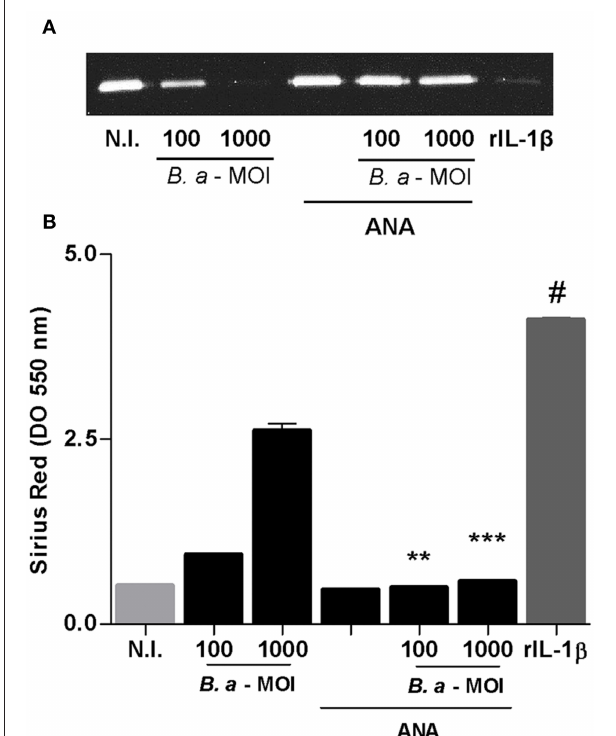
FIGURE 6 | IL-1 β is involved in the induction of a profibrogenic phenotype. LX-2 cells were infected with B. abortus at MOI of 100 and 1000 in the presence or not of ANAKINRA (ANA). Determination of MMP-9 at 24h post-infection in culture supernatants by zymography (A) . Recombinant human IL-1- β , (rIL-1 β ) (50ng/ml) was used as a positive control. Quantification of collagen deposition was revealed by Sirius red staining by OD readings at 550nm at 10 days post-infection (B) . Data are given as the means ± SD of duplicates. ** P < 0.01; *** P < 0.001 vs. untreated cells. # P < 0.001 vs. non-infected cells